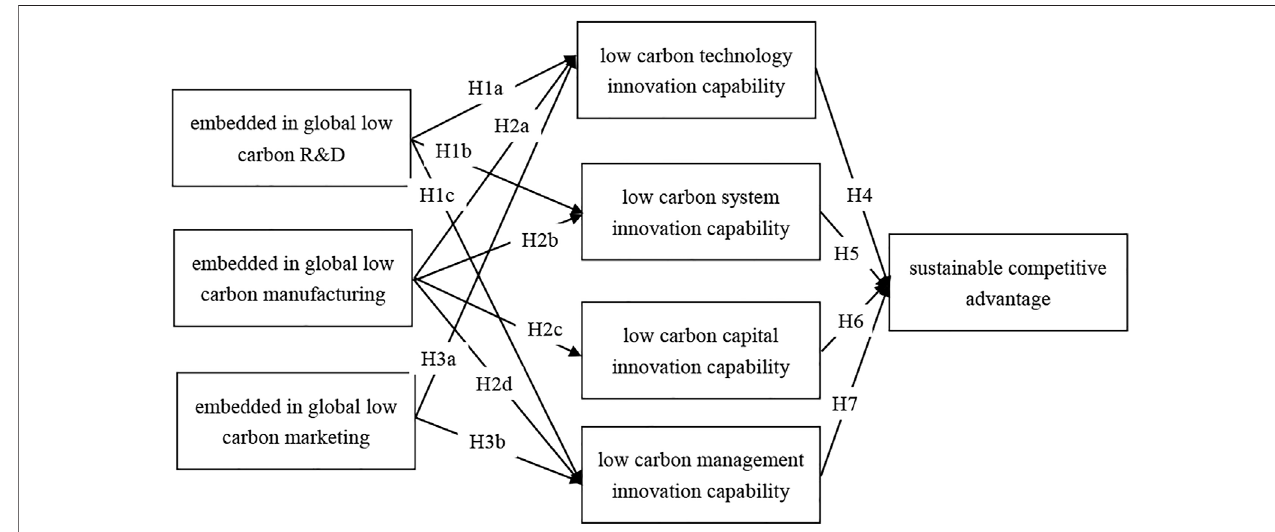
FIGURE 1 | Conceptual model of the in fl uence of embedment in the GVC on a sustainable competitive advantage.